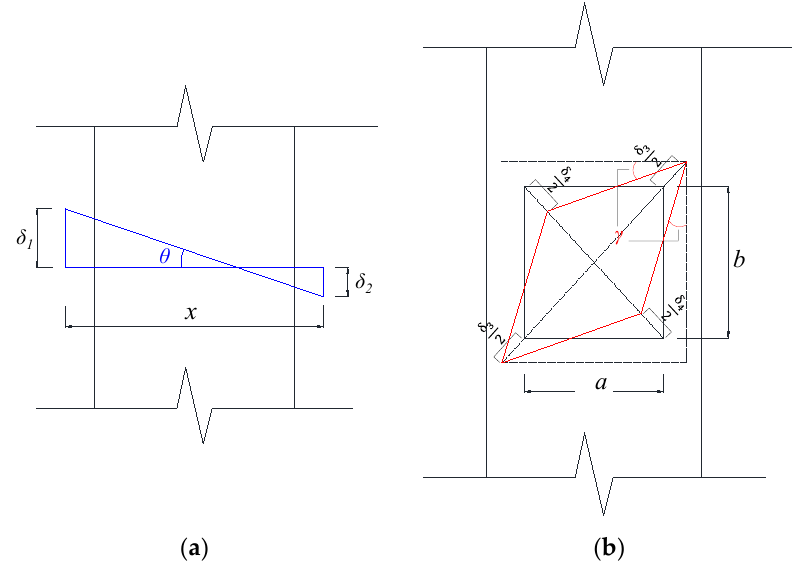
Figure 10. Calculation method of deformation: ( a ) rotation angle by flexural deformation; ( b ) shear strain by shear deformation.